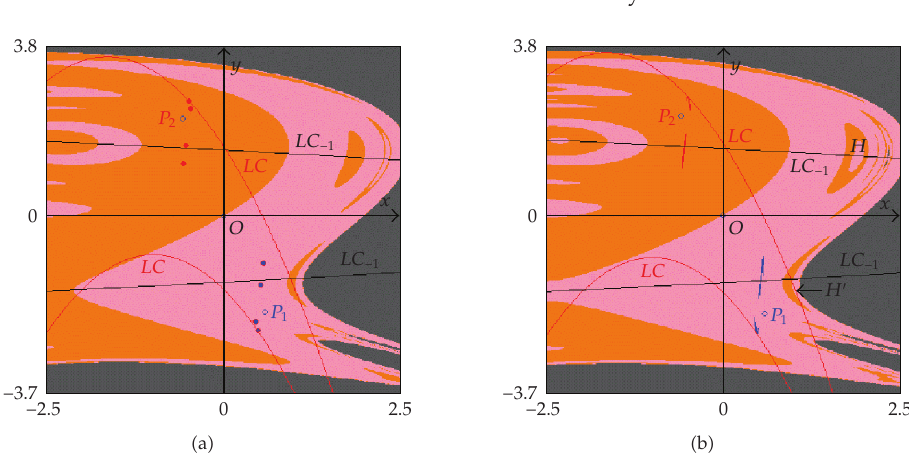
Figure 9: Basins of attraction. Basin B 1 of the attractor located around P 1 is in pink, whereas basin B 2 , whose points lead to the attractor around P 2 , is in orange. In (cid:5) a (cid:6) , for e (cid:8) 3 . 43, attractors A 1 and A 2 are two coexisting 4-cycles. In (cid:5) b (cid:6) , for e (cid:8) 3 . 56 , the attractors are two coexisting two-piece chaotic attractors.